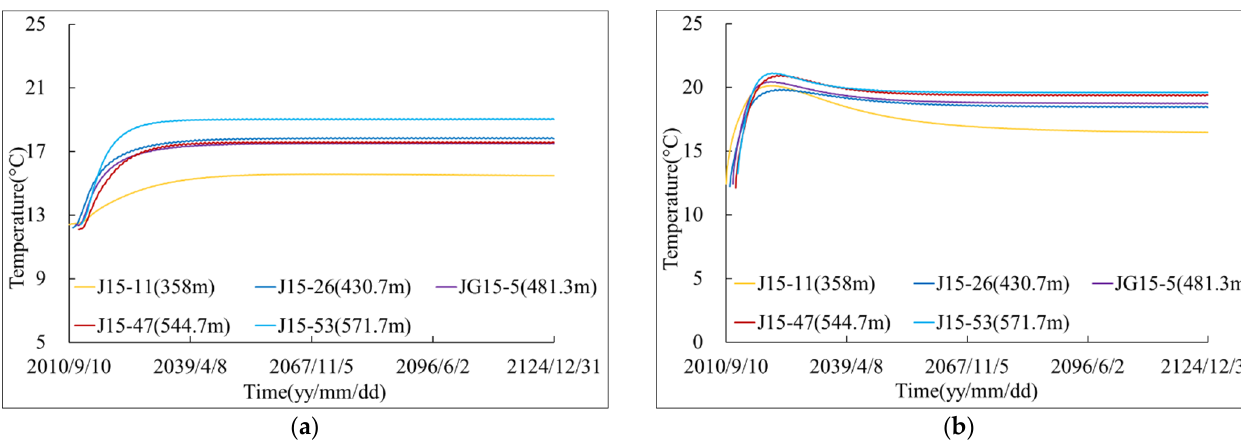
Figure 14. Change process line of temperature inside arch dam. ( a ) Design condition; ( b ) Actual condition.